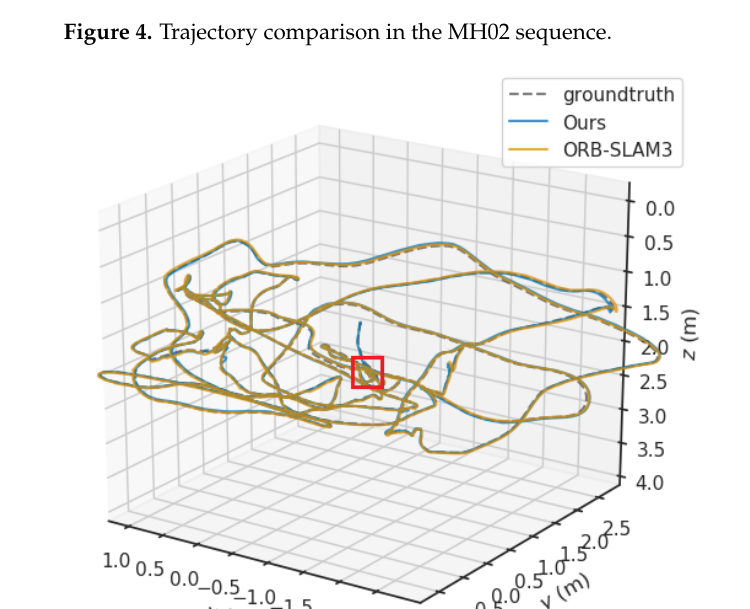
Figure 4. Trajectory comparison in the MH02 sequence.